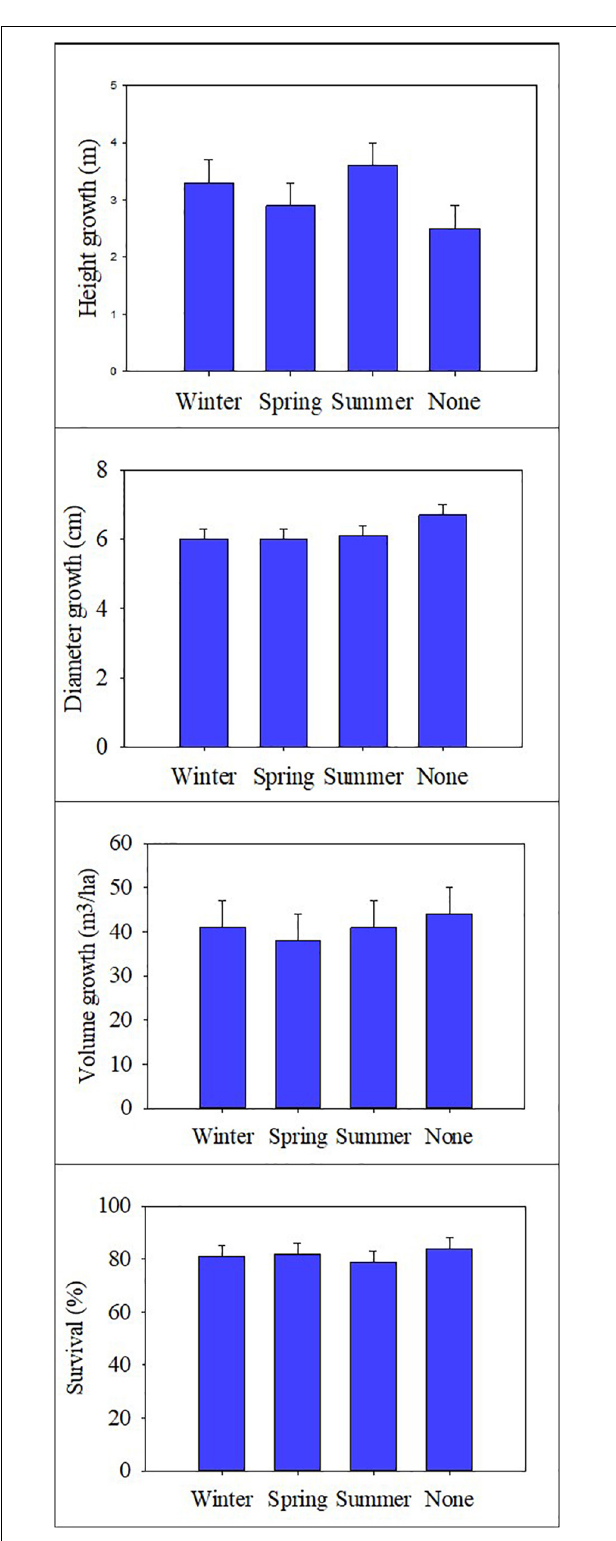
FIGURE 2 | The estimated survival, diameter growth, height growth, and volume growth ± 1 SE of longleaf pine after 23 years of winter, spring, summer biennial burning and an unburned treatment.